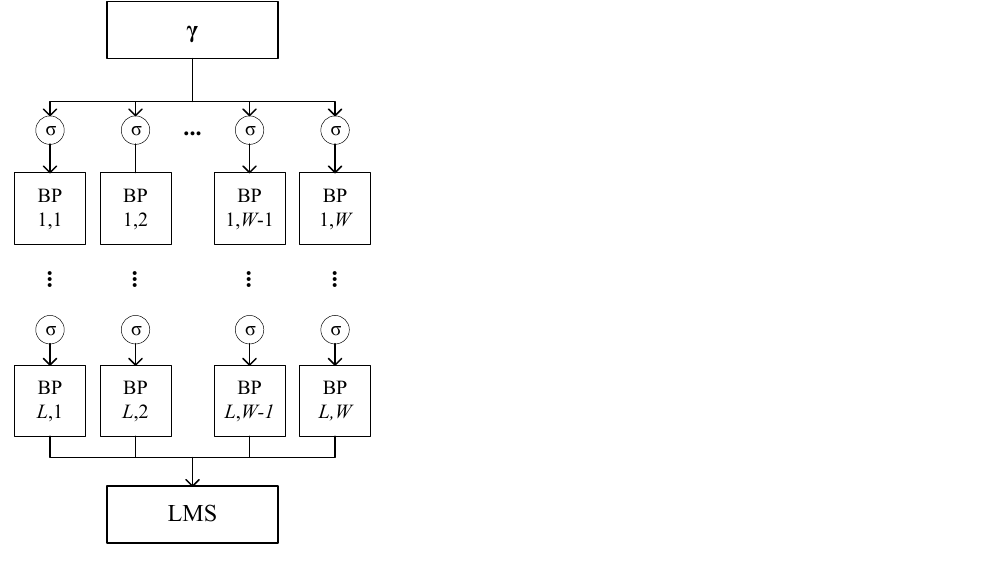
Figure 1. An mRRD ( W , L , I ) structure. “ γ ” represents a log-likelihood-ratio vector. A circle with “ σ ” denotes a random permutation, and a square with “BP” stands for I BP iterations. “LMS” denotes the least metric selector.